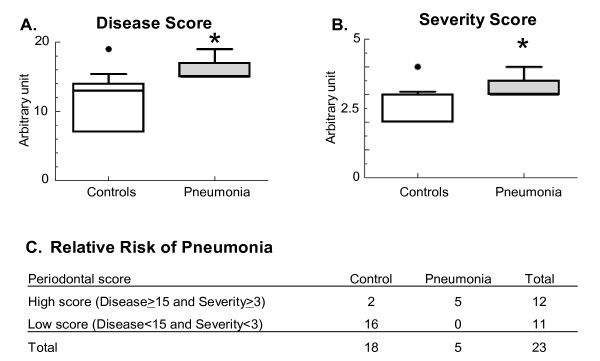
Relative risk for postoperative pneumonia in relation to periodontal diseases. Presence of periodontal diseases and disease severity were significantly greater in patients with postoperative pneumonia. (A-B): Data were expressed as "box and whiskers: 10–90 percentile" and compared using the non-parametric Mann-Whitney test (A): Disease score: periodontal diseases in every patient were evaluated. A score number was ordered to each diagnose, and the sum of the scores appears as "disease score". * = p = 0.0018 (B): Severity score is the number of co-existing periodontal diseases in each patient. * = p = 0.031; (C): Analysis of Relative Risk: "High score" patients had a Disease Score of ≥ 15 and a Severity Score of ≥ 3. Number of patients is shown in each groups. Chi-square test was performed, one-sided p value was calculated. *p < 0.0001; Relative risk: 3.5; confidence interval (95%): 1.085 to 11.29.